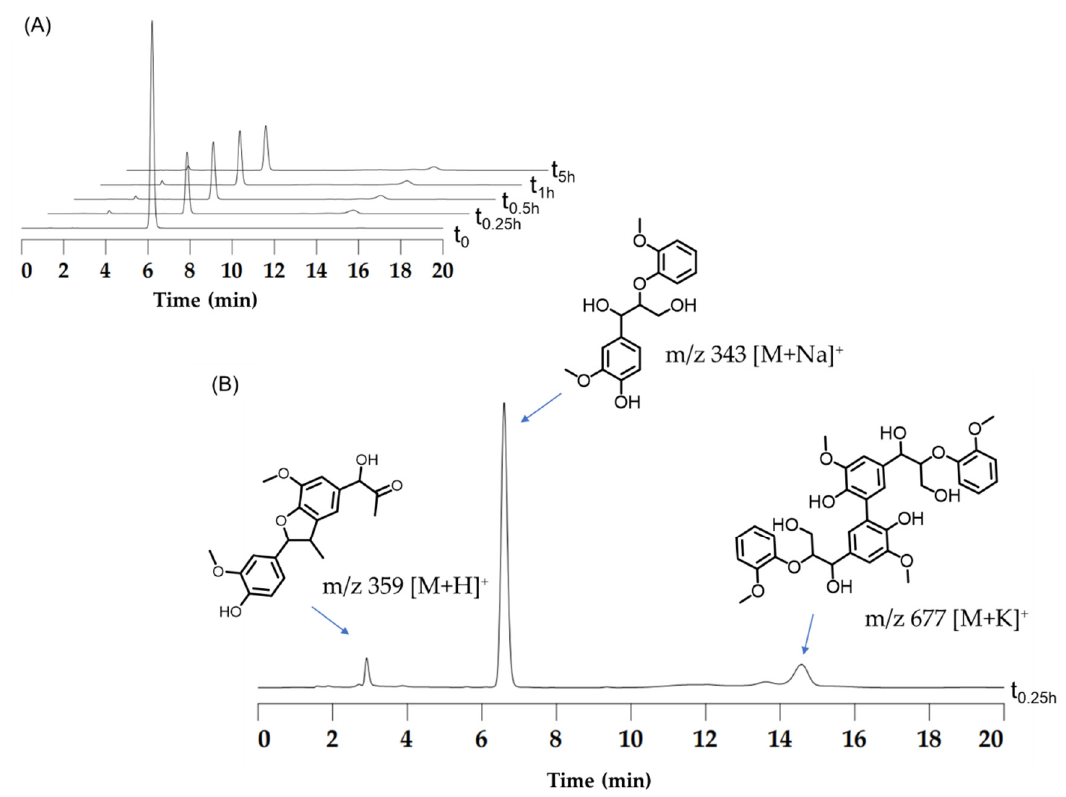
Figure 7. ( A ) HPLC traces as monitored at 280 nm, showing the oxidation of 2.5 mM of GGE cata- lyzed by F43Y/T67R/P88W/F138W Mb (5 µ M) in the presence of H 2 O 2 (2 mM) in potassium phosphate buffer (pH 7.0). ( B ) Analysis of the products by mass spectrometry in positive mode, showing m/z 359 [M+H] + and 677 [M+K] + .